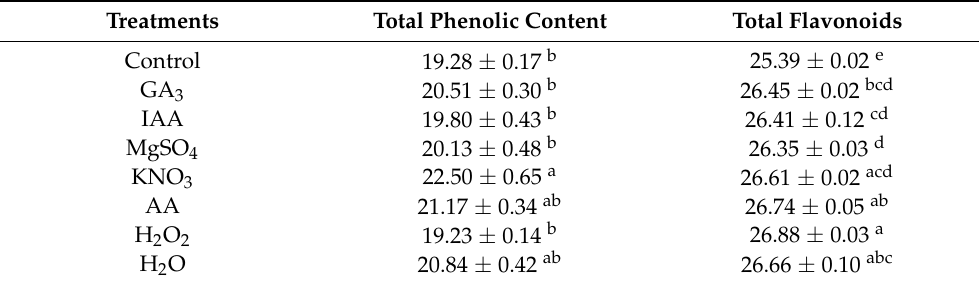
Table 3. Total phenolic content (mg of GA g − 1 of extract) and concentration of flavonoids (mg of RU g − 1 of extract) after different priming treatments in the aboveground part of wheat seedlings.